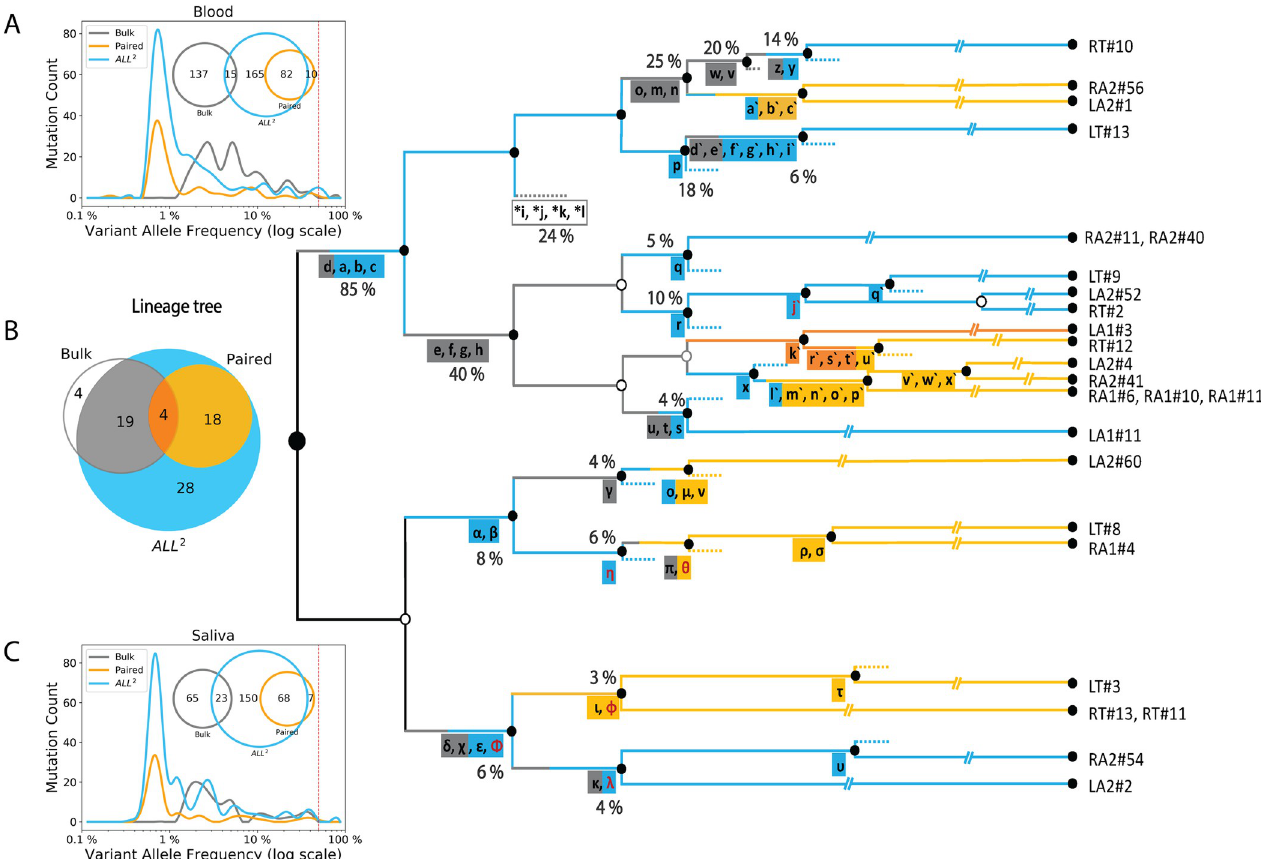
Fig 2. Calls from All 2 enable reconstruction of high-resolution lineage tree. (A, C) Application of All 2 to iPSC clones discovers more variants (cyan) than analysis of deeply sequenced bulk tissues (gray) or pairwise comparison of clonal lines and the bulk (orange). The approach also calls variants across entire VAF spectrum. Analysis of bulk may discover variants with intermediate VAF (1%-10%) which are not sampled in clones. For the displayed comparison, variants with at least two supporting reads in the bulks are considered for each discovery approach. ( B) Lineage tree reconstructed from the analysis of 25 clones from an adult individual. Variants discovered from either bulks (gray) or from pairwise (orange) comparisons provide limited information as compared to All 2 , which is the most comprehensive. Multiple branches in the lineage tree can be traced when using additional variants (cyan) discovered by applying only the All 2 approach, which is also reflected in the Venn diagram. SNVs found only in the bulk tissues are marked with asterisks and define putative branch not sampled by clones. INDELs are colored in red and SNVs are colored in black. The percentage values next to branches denote the average fraction of the cells in bulks carrying the mutations. Clone names are shown on the